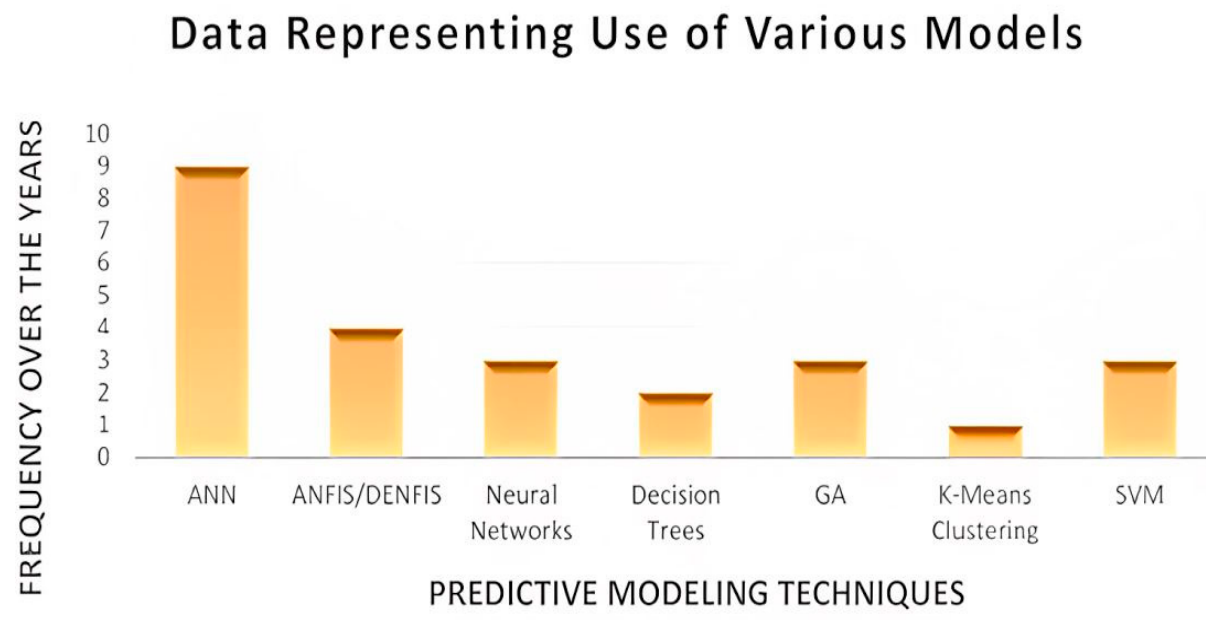
Figure 3. Statistical data representation of frequently used AI modeling techniques.